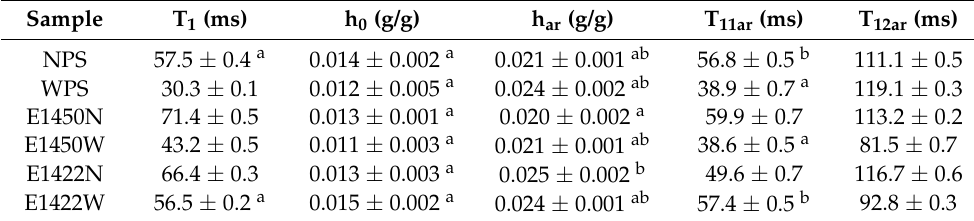
Table 2. Hydration values saturating all sorption sites in the aerogel and corresponding to their relaxation